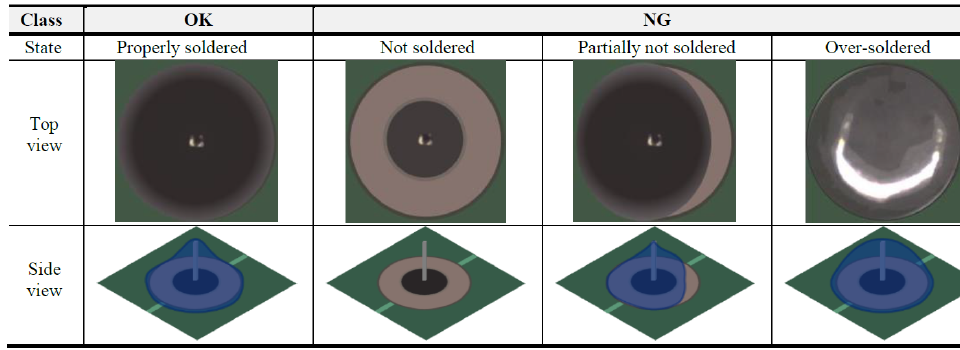
Figure 4. Examples of non-defective (OK) and defective (NG) soldered pin. The blue area in the side view shows the result of soldering. Defects appear in the overall product